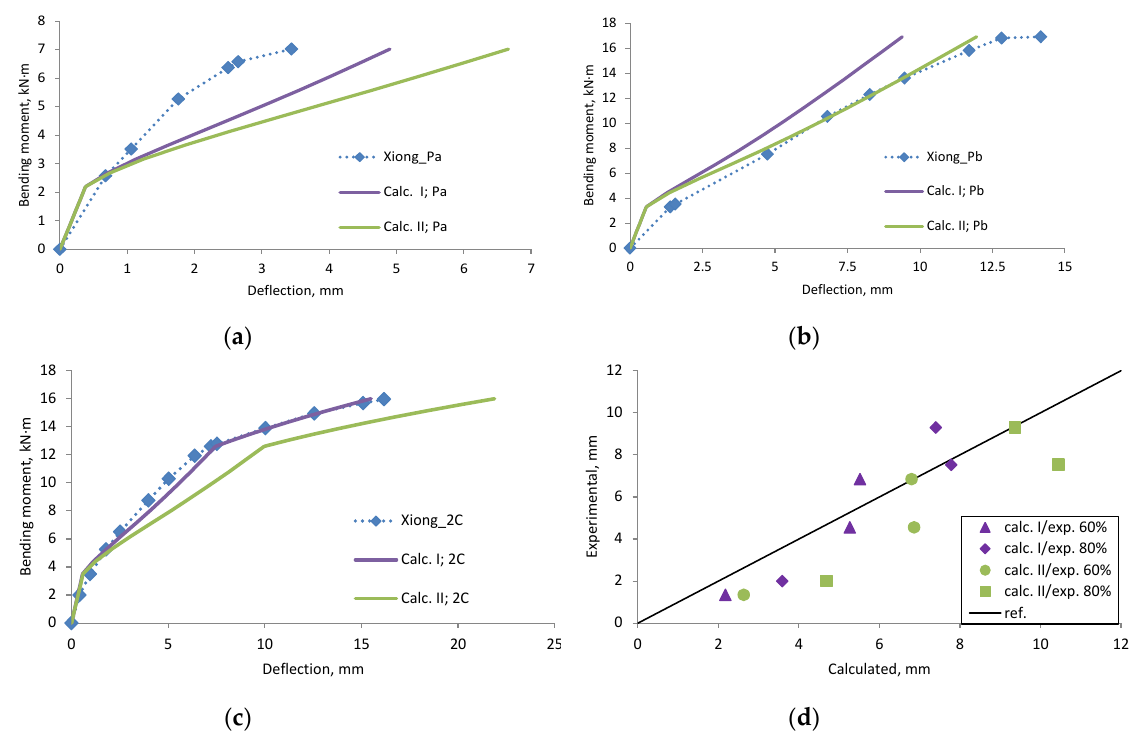
Figure A22. Xiong et al., 2007 [44] research beams deflection compared with calculated, ( a ) beam Pa; ( b ) beam Pb; ( c ) beam 2C; ( d ) scatter of the results at 60% and 80% of the ultimate load.